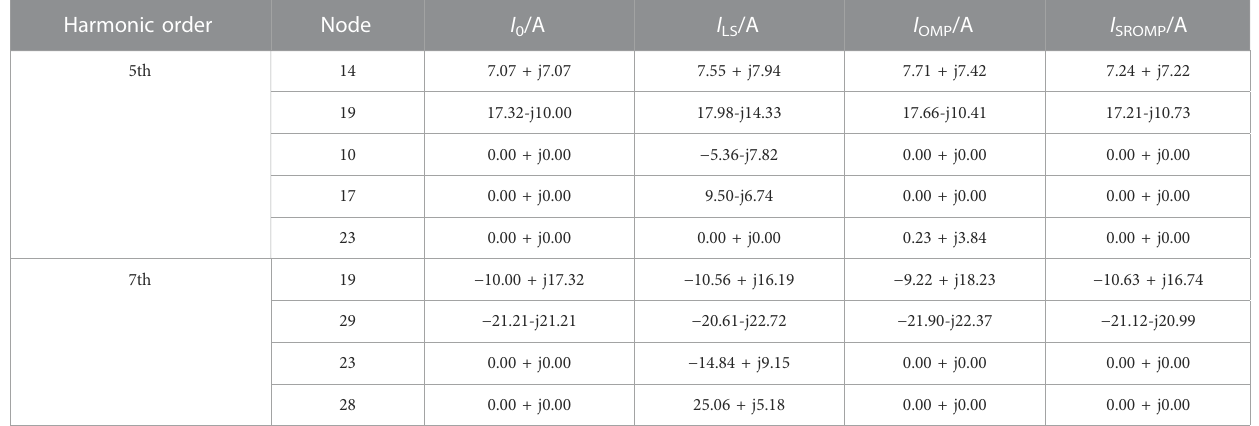
TABLE 5 Harmonic injection current estimation results. Harmonic